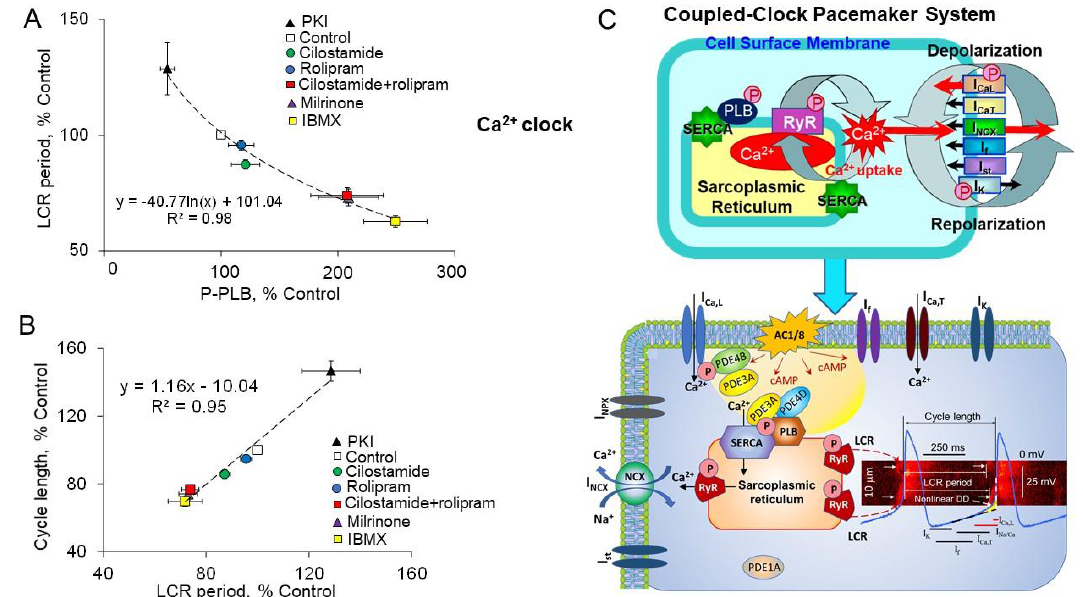
Figure 12. Regulation of the LCR period and spontaneous SANC cycle length through phosphorylation-dependent mechanism. ( A ) The relative effects of a PKA inhibitor PKI (5 µmol/L, n = 4 SANC), PDE3 (0.3 µmol/L cilostamide, n = 4 SANC), or PDE4 (2 µmol/L rolipram, n = 4 SANC) inhibitors alone or dual PDE3 + PDE4 inhibition (n = 7 SANC), IBMX (100 µmol/L, n = 5 SANC) or PDE3 inhibitor milrinone (50 µmol/L, n = 6 SANC) to alter the LCR period are linked to their effects to alter PLB phosphorylation at PKA-dependent Ser 16 site. ( B ) The relative effects of PKI and diverse PDE inhibitors to alter the spontaneous cycle length are linked to their effects on the LCR period. Note that the effects of dual PDE3 + PDE4 inhibition to alter PLB phosphorylation or the LCR period or cycle length are identical to effects of high (50 µmol/L) milrinone concentration ( A , B , modified from [11,40,41]). ( C ) Top: schematic presentation of the “coupled-clock” pacemaker system; bottom: fine regulation of the “coupled-clock” system by high basal cAMP level, created by constitutive Ca 2+ -activated ACs (AC1 and AC8), which is under tight control of constitutive dual PDE3 and PDE4 activation that works in concert to decrease cAMP and cAMP-mediated PKA-dependent phosphorylation at key locations, i.e., L-type Ca 2+ channels and SERCA-PLB complex (see text for details).